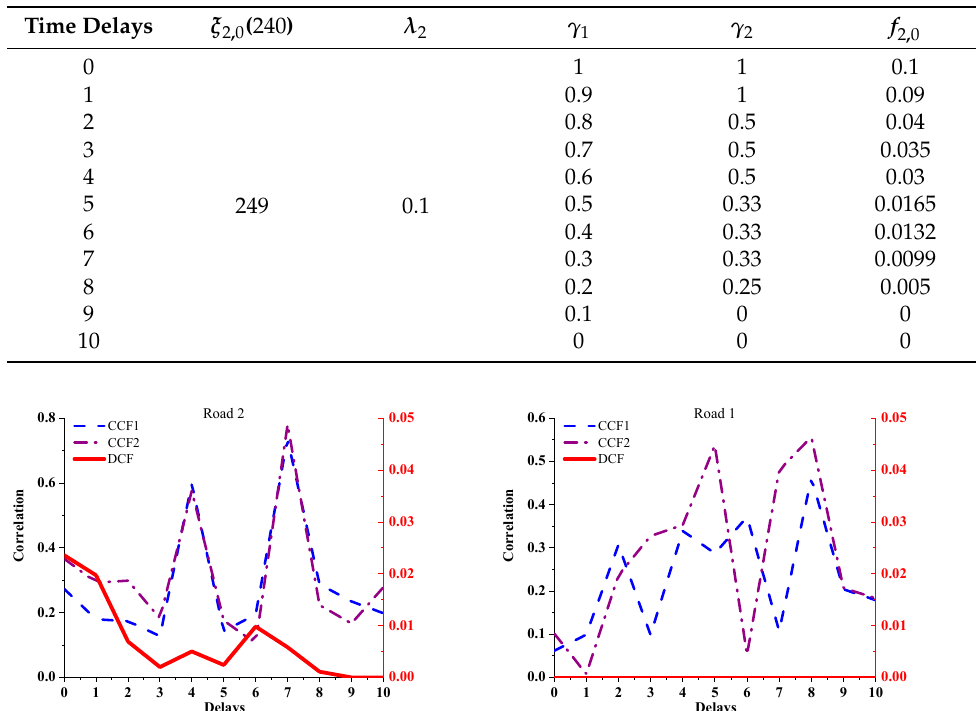
Table 2. Traffic correlation strength between road 2 and TR with different time delays.